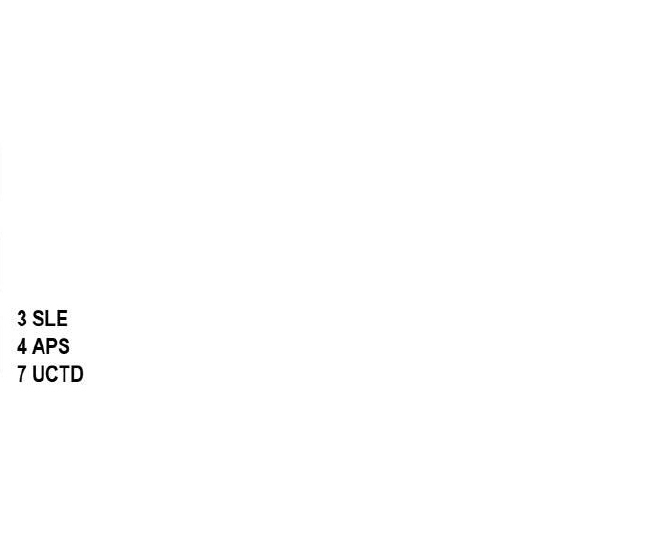
Table 1. Main demographic, laboratory and clinical features of four aPL carriers developing throm- botic events.